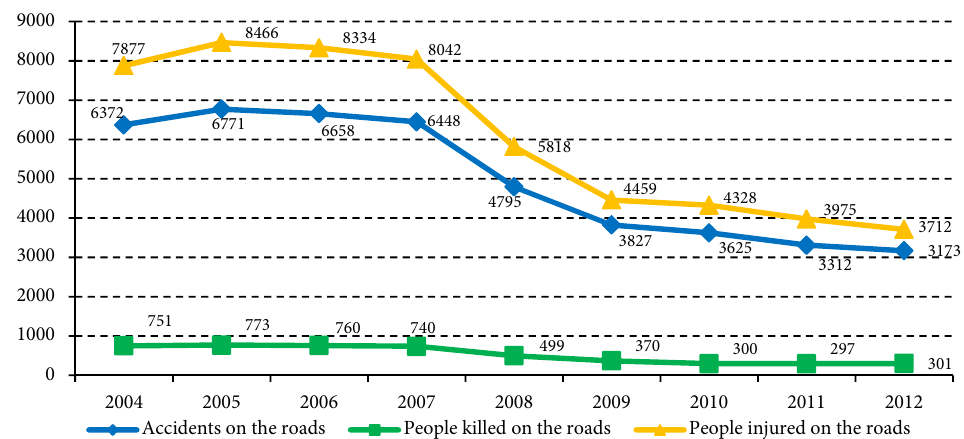
Fig. 3. Safety indicators on roads of Lithuania in 2004–2012 (data from “Statistics of valid traffic accidents in Lithuania